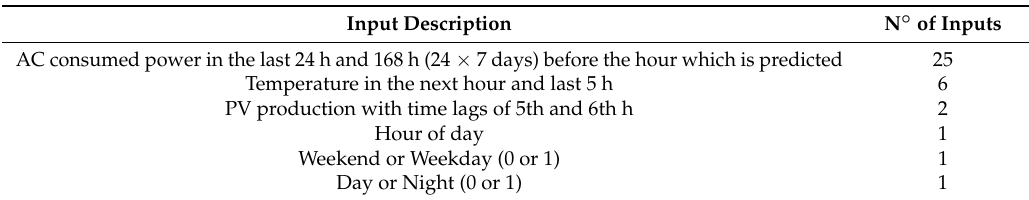
Table 2. Features and target columns for the machine-learning model.